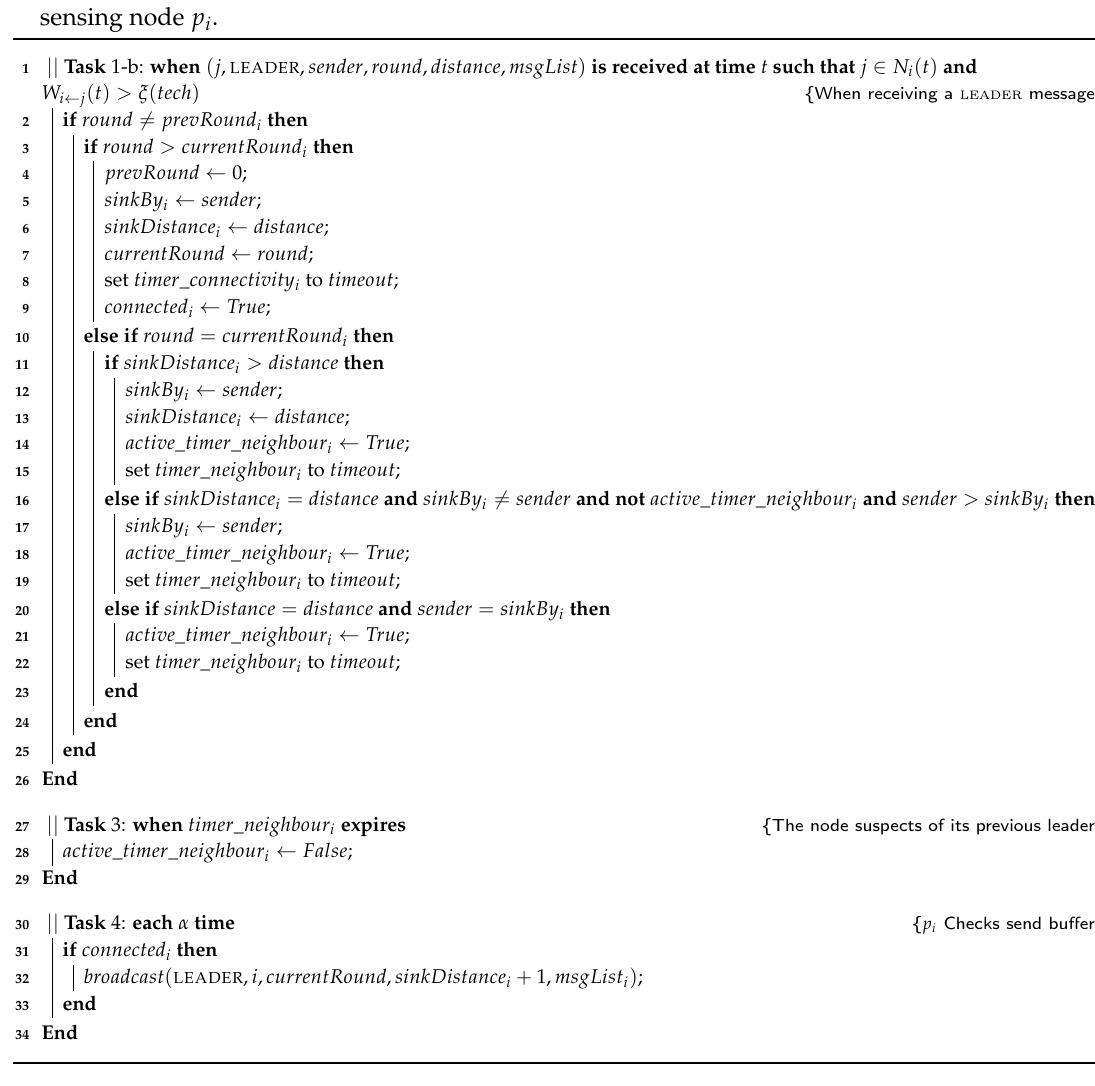
Algorithm 3: The modifications required by LBR2 to the previous algorithm to be executed by any sensing node p i